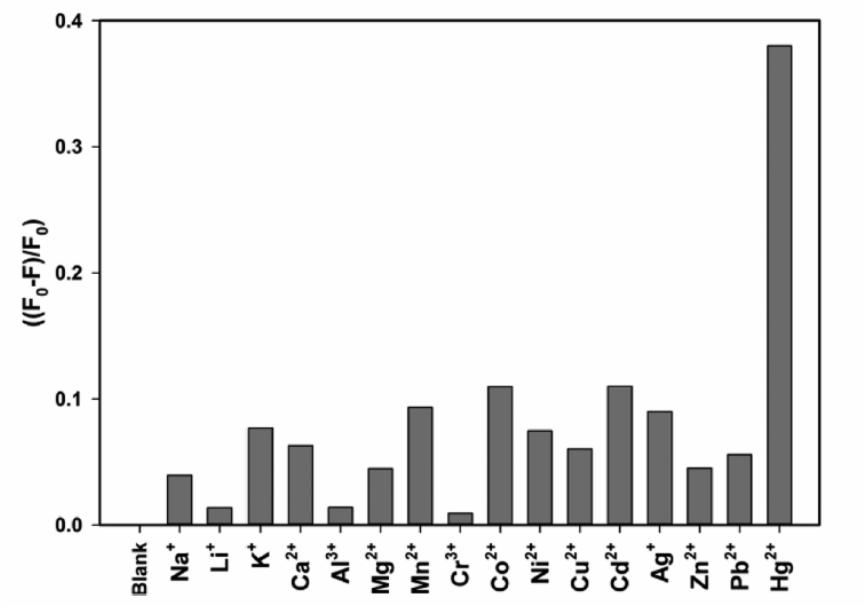
Fig. 17. The quenching ratio ((F -F)/F ) of fluorescence response of SBA-15-HA aqueous dispersion in the 0 0 presence of various metal ions at pH 7.0